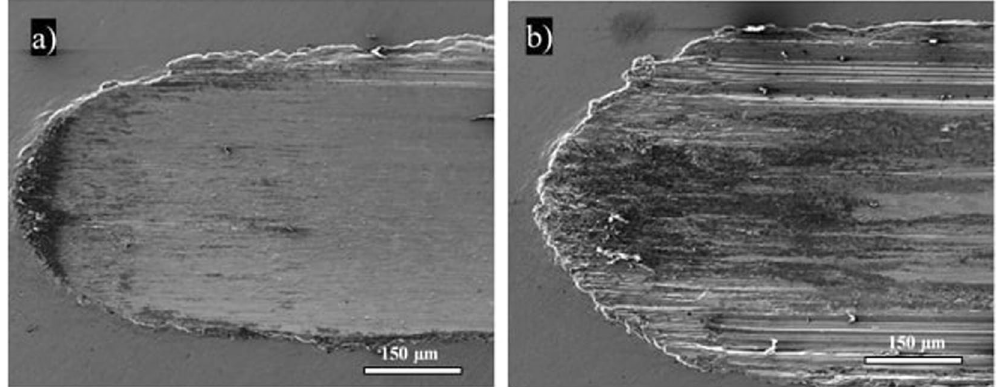
Figure 6. SEM images of the wear tracks on the pure Al specimen tested at 25 °C ( a ) and 100 °C ( b ).